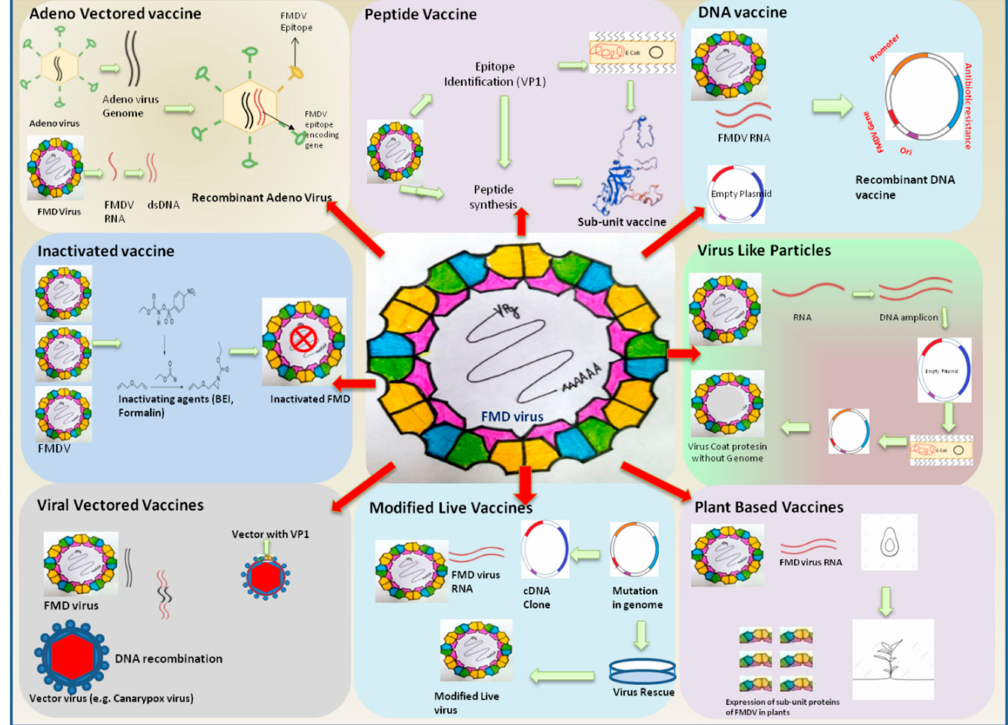
Figure 2. Trends in advances in vaccines against FMDV. Inactivated vaccines are most widely used, but, as they su ff er from several demerits, the search for new generation vaccines is on. Several alternatives such as Adeno virus vectored vaccine and virus-like particles have been shown to be promising considerationsfor FMD control in India. The brief procedure used for development of these vaccines is depicted in the